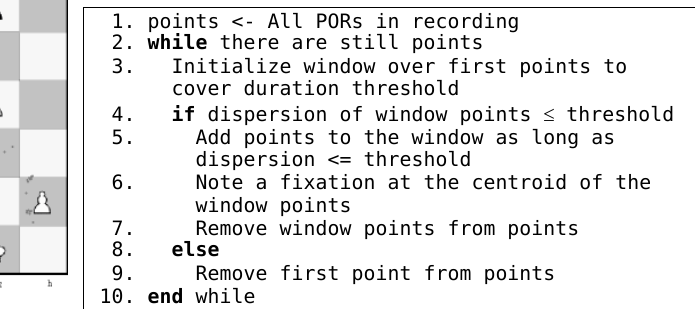
Figure 5: Stimulus with PORs. A selection of PORs that constitutes a single fixation is highlighted. Figure 6: The I-DT algorithm of Salvucci and Goldberg